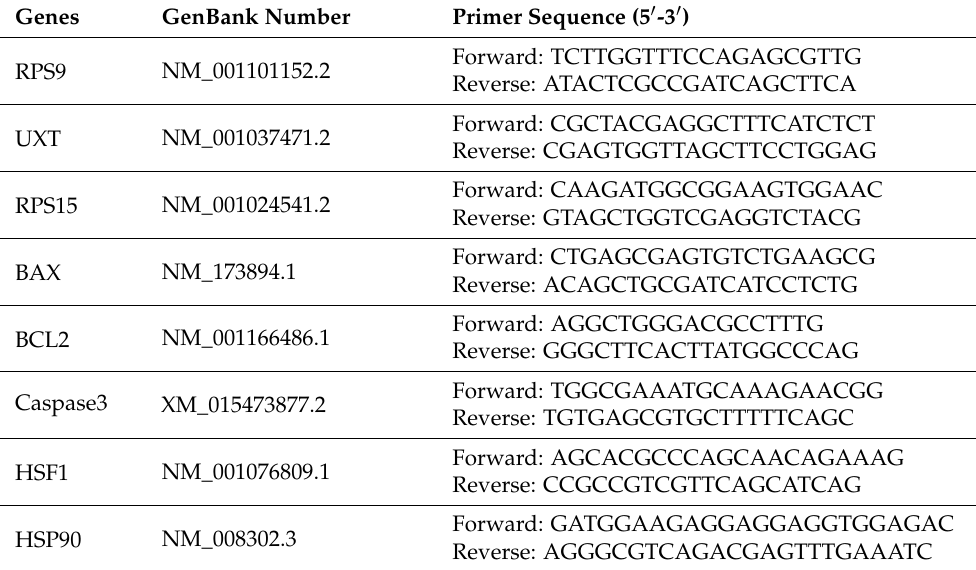
Table 1. Sequences of primers for the real-time PCR